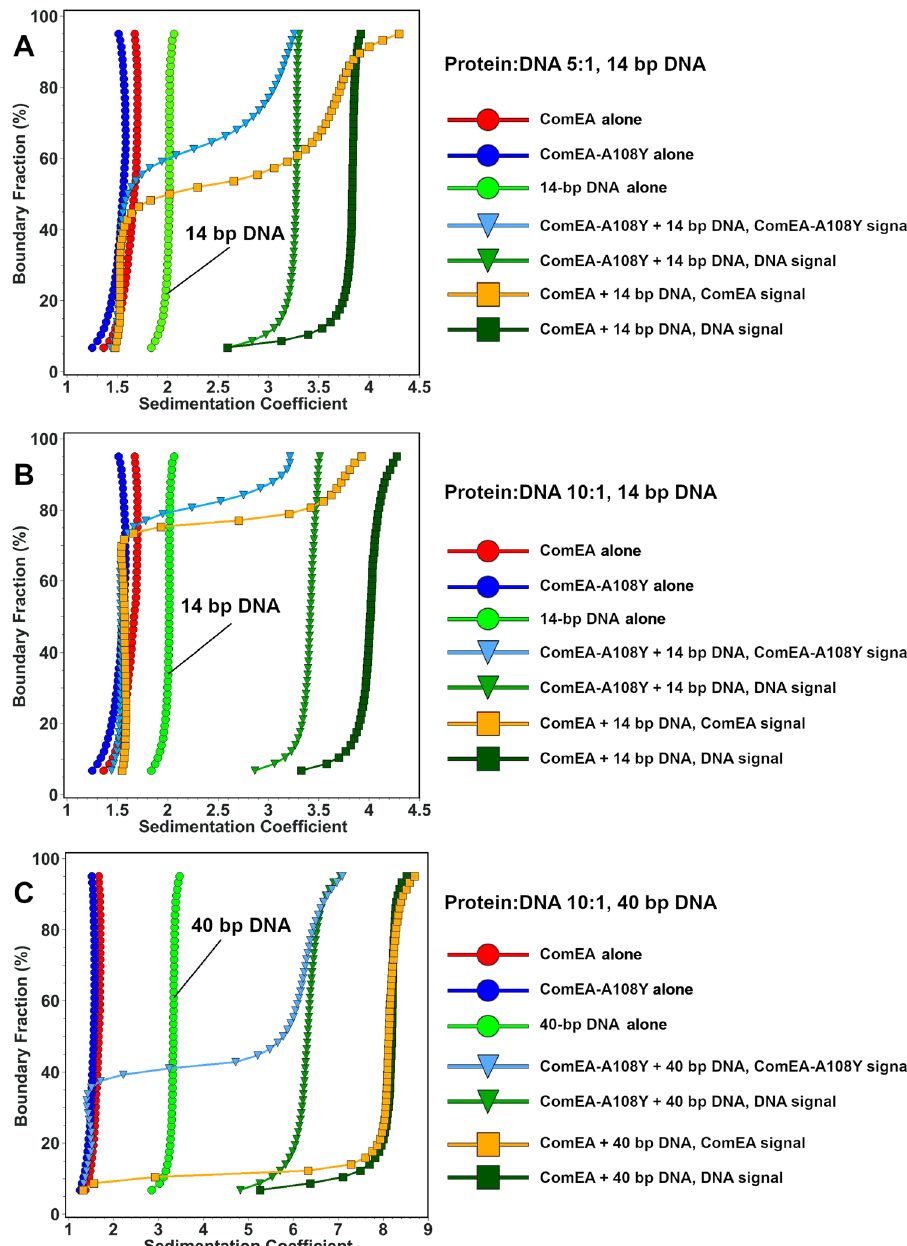
Fig. 5 | AUC analysis of ComEA and ComEA-A108Y, and their interactions with 1.5 μ M DNA. A and B Mixtures 5:1 and 10:1 molar ratios of wild-type ComEA Gs and ComEA Gs -A108Y with the 14-bp DNA molecule, respectively. Here, the DNA signals still suggest full saturation with protein, but the protein signals show more het- erogeneous sedimentation coef fi cient distributions, consistent with more rapid exchange with the protein-DNA complex, which suggests a faster k off rate. More than90%oftheDNAiscomplexedwithprotein,shiftingthe14bpDNAdistribution from2.0Sforthecontrolbyitselfto3.3Sforthemutant,and3.9Sforthewild-type inpanelA.InpanelB,increasingtheproteinconcentrationto10:1,marginallyshifts the DNA sedimentation for the wild-type further to about 4.0S, while barely affecting the DNA sedimentation when mixed with the mutant. C Integral sedi- mentation coef fi cient distribution overlays for the deconvoluted protein and DNA signals from the 10:1 mixture of ComEA Gs and ComEA Gs -A108Y with 1.5 μ M of the